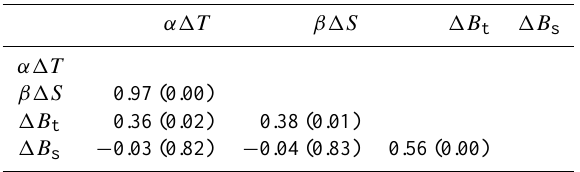
Table 5. Correlation tests between NCEP buoyancy fluxes and WMDW T and S . The number in brackets is the probability of get- ting a correlation as large as the observed value by random chance. A very low probability means that the correlation is